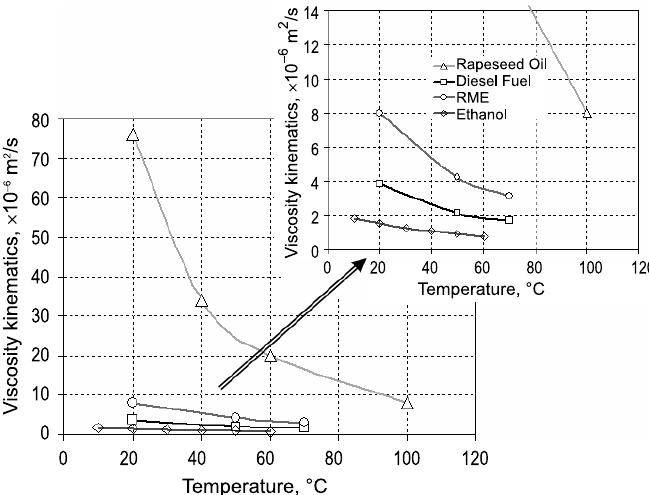
Fig. 1. Dependence of different fuels viscosity upon